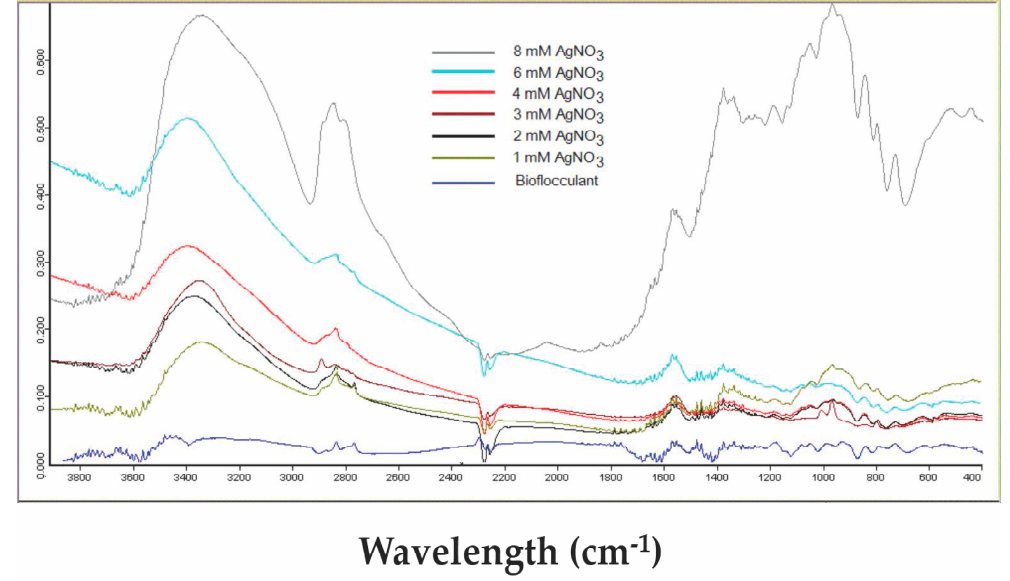
Figure 5. FT-IR spectrum of AgCl-NPs, assembled on the polysaccharide-based bioflocculant of A. chroococcum XU1 in different concentrations of Ag + .